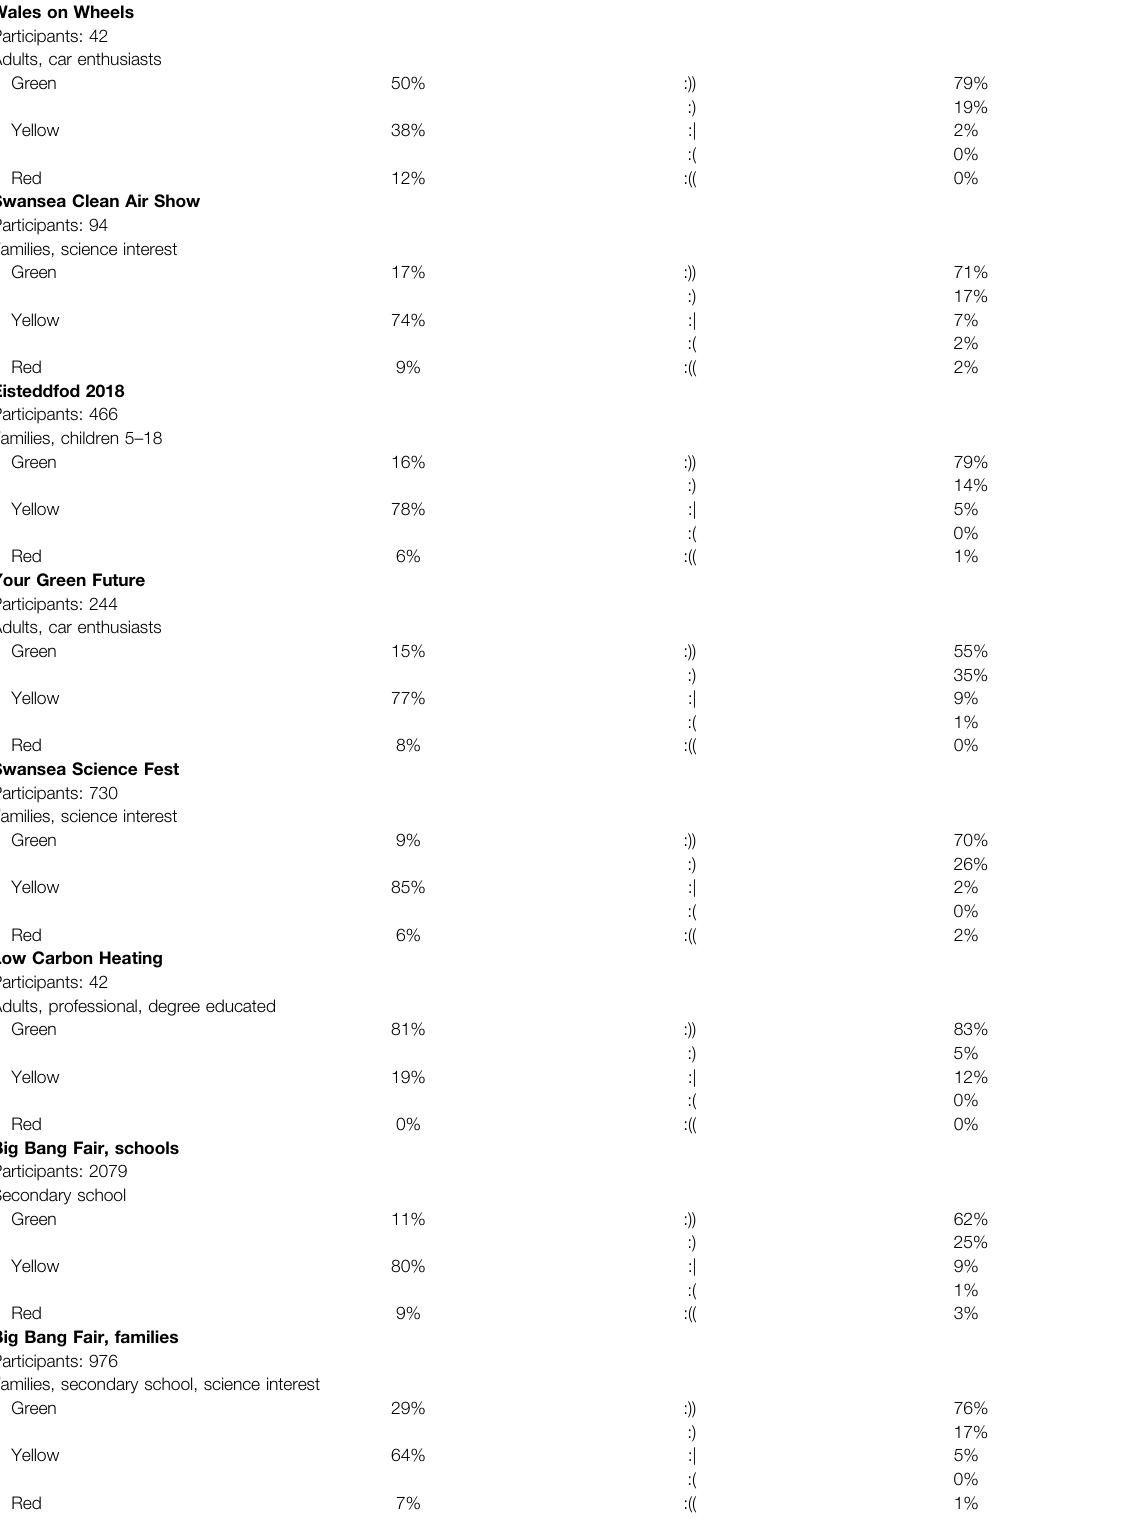
TABLE 1 | These seven events were attended by The Hydrogen Bike with one to three keywords describing the assumed demographics of the attendees of the events. In responsetothetwoquestionsabouttheparticipants ’ feelingstowardshydrogen,thepercentageofeachcolouroftokenallocatedandwherethosetokenswerereturnedis listed.:)):):|:(and:((representthedarkgreen,lightgreen,yellow,orangeandredfacesonthetubesinFigure2respectively.Fulldataavailableinthe SupplementaryTableS1